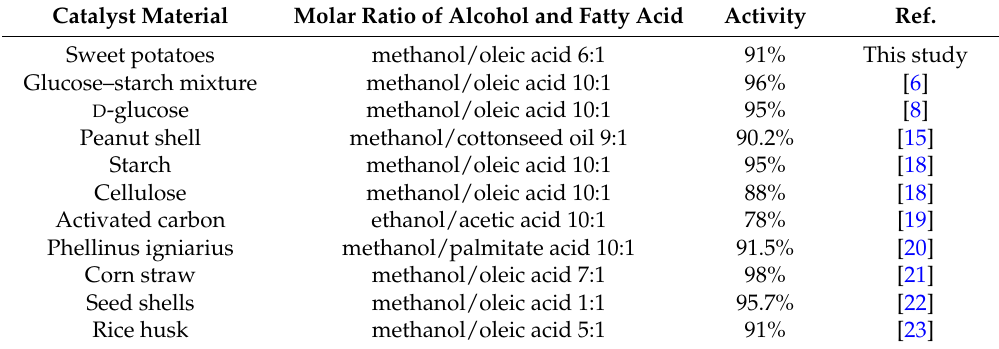
Table 2. The esterification activity of the catalyst in this study and other recent typical examples. Catalyst Material Molar Ratio of Alcohol and Fatty Acid